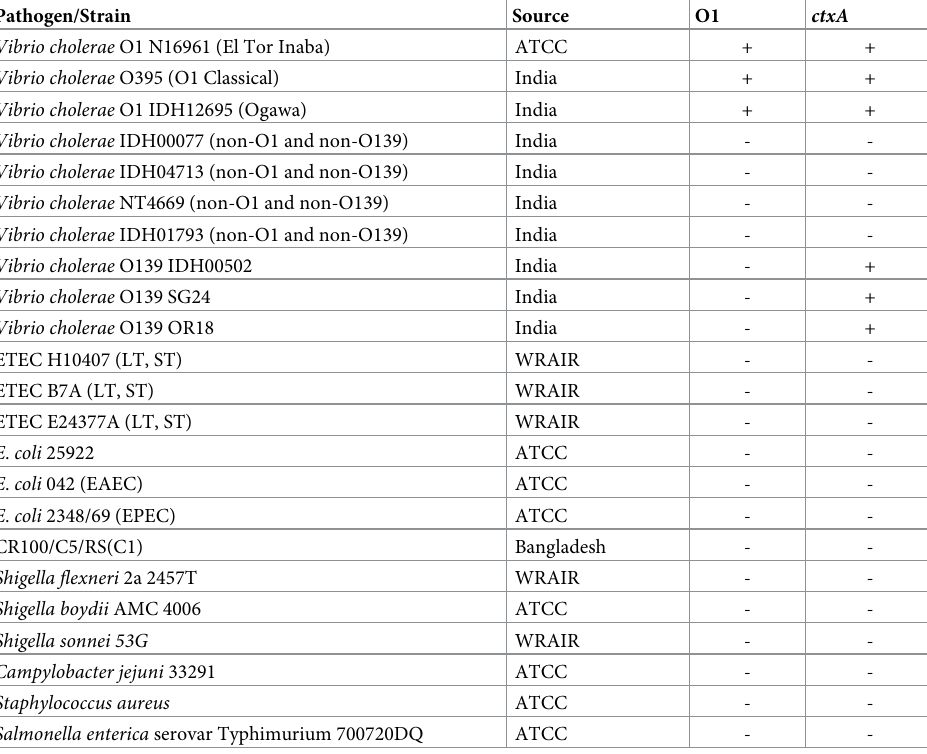
Table 2. List of strains used for the evaluation of the specificity of cholera RLDT. Pathogen/Strain Source O1 ctxA Vibrio cholerae O1 N16961 (El Tor Inaba) ATCC